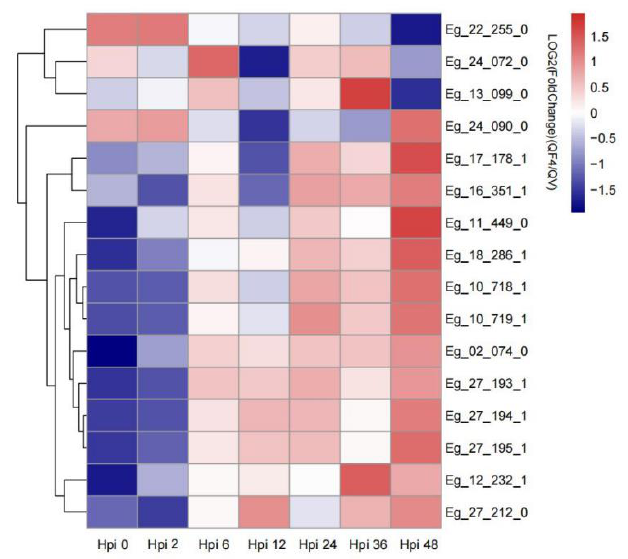
Figure 5. Expression of immune-related genes in E. grisescens after ingestion with EcobNPV-QV and EcobNPV-QF4. Each square represents each gene, and the color from red to blue indicates the nor- malized gene-expression with FPKM from large to small. Hpi: hour post ingestion.